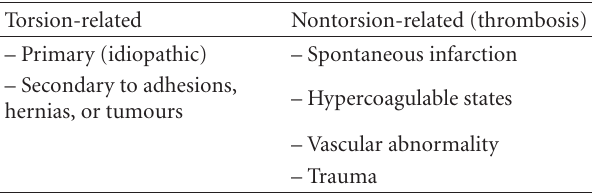
Table 1: Classification of omental infarction [2, 8, 13]. Table 2: Summary of patient